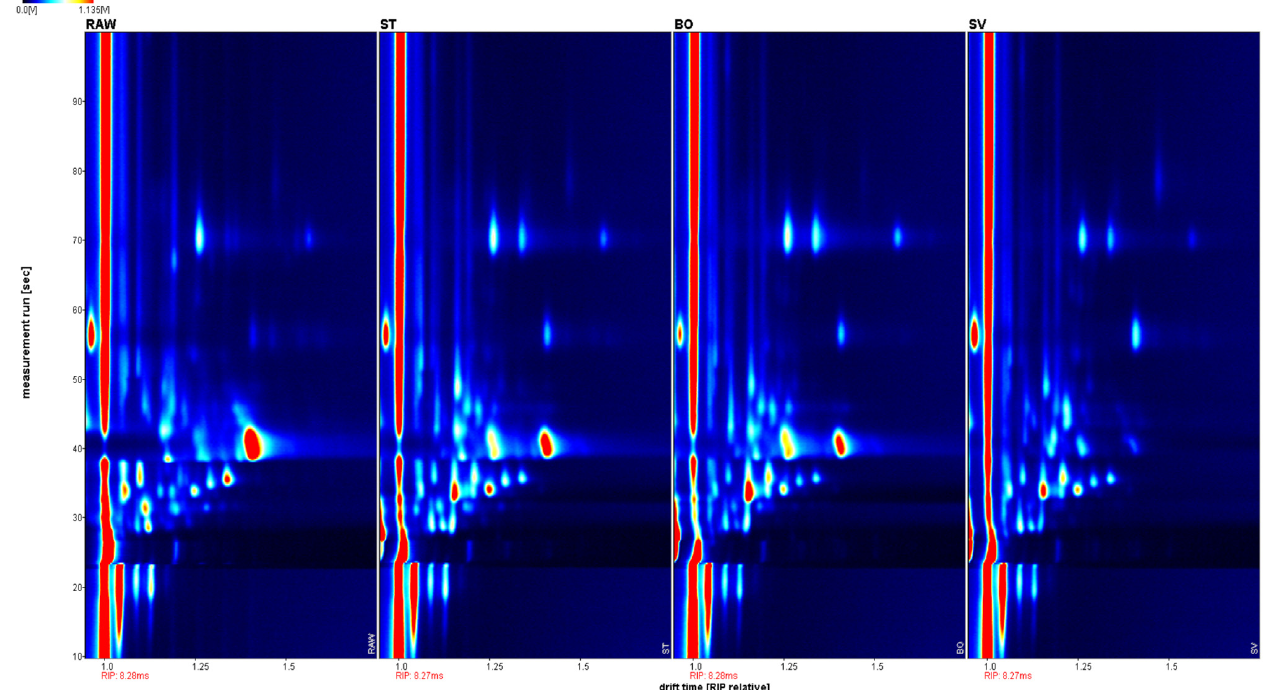
Figure 7. Contrast spectrum of volatile compounds in squid ( Symplectoteuthis oualaniensis ) mantle muscle from different cooking methods. The topographic plot of RAW was selected as a reference, while the plots of other samples were deducted from the reference. Each point on the spectrum represents a volatile component and its color indicates the signal intensity. Red indicates high intensity, and blue indicates low intensity. From left to right, the sample treatments were RAW, ST, BO, and SV, respectively. RAW: raw squid; ST: steaming; BO: boiling; SV: sous vide.